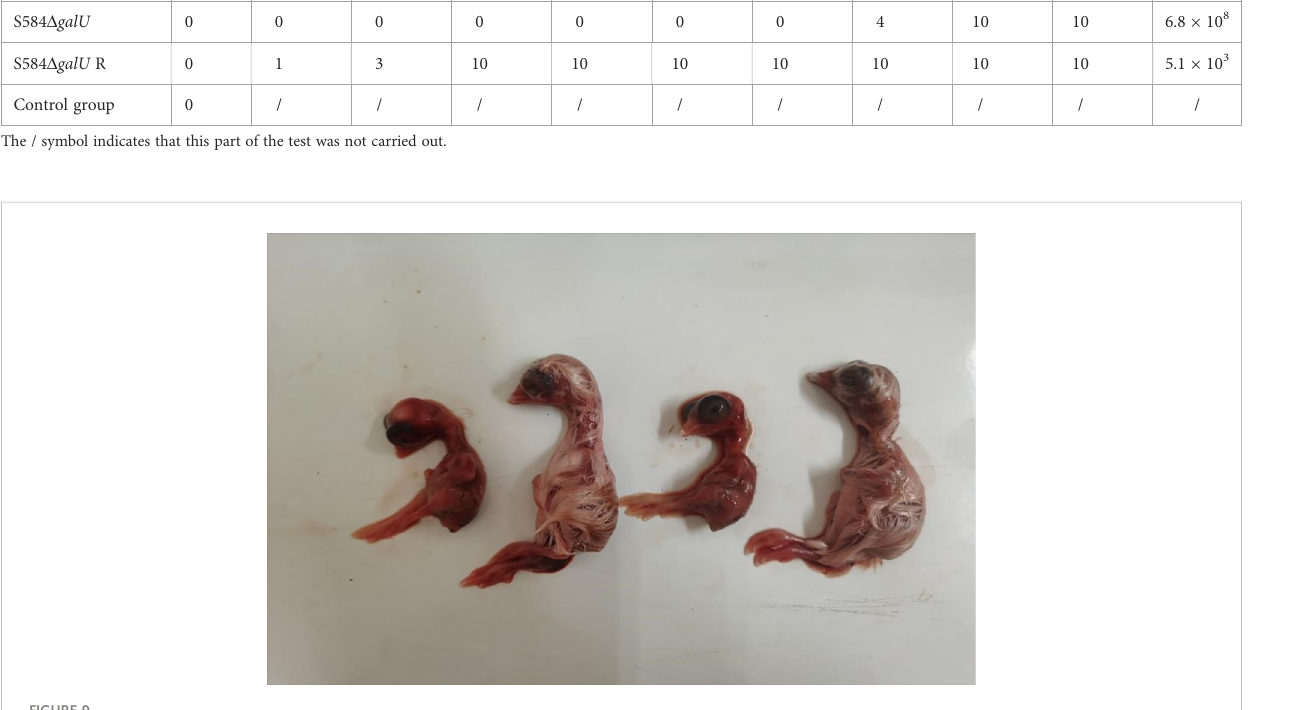
FIGURE 9 Pathogenicity in chicken embryos (1 × 10 3 CFU). Chicken embryos are ordered S584, S584 D galU , S584 D galU R, and control strains from left to right.